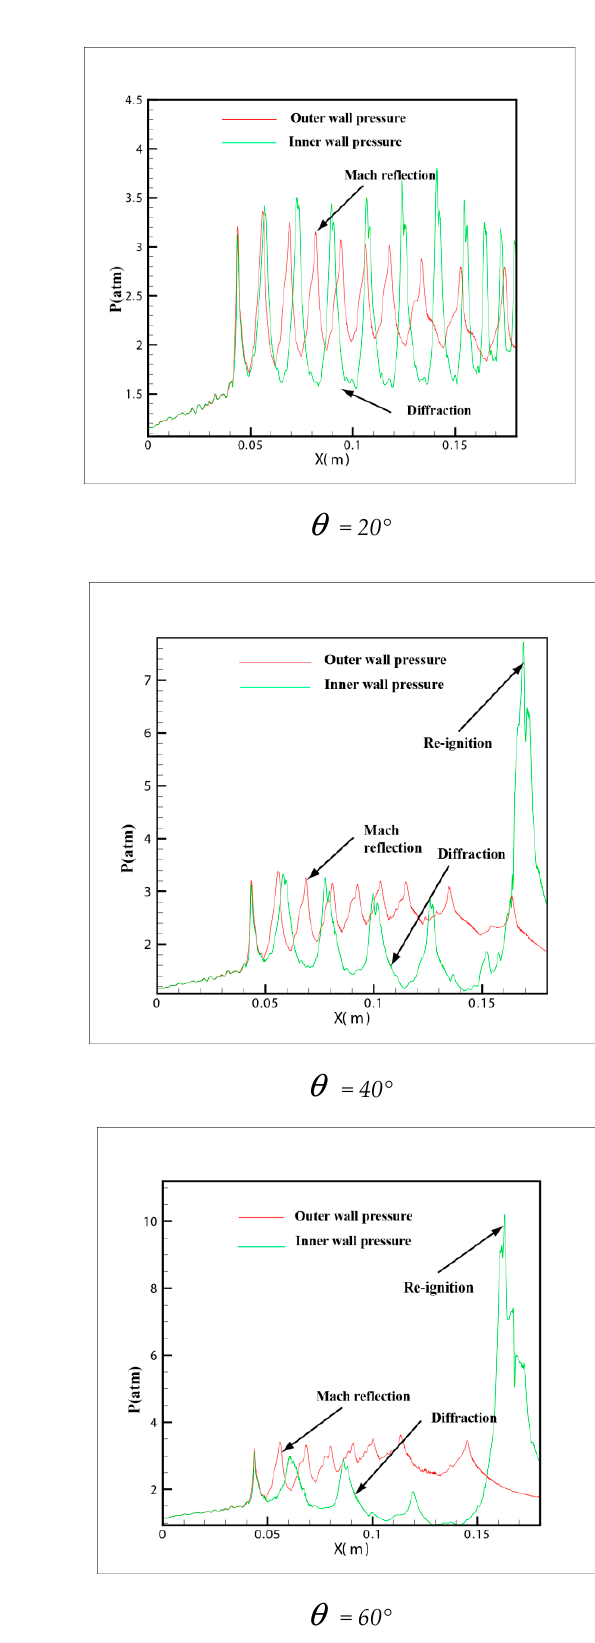
Figure 8. The history pressure curves of inner and outer bend pipe.